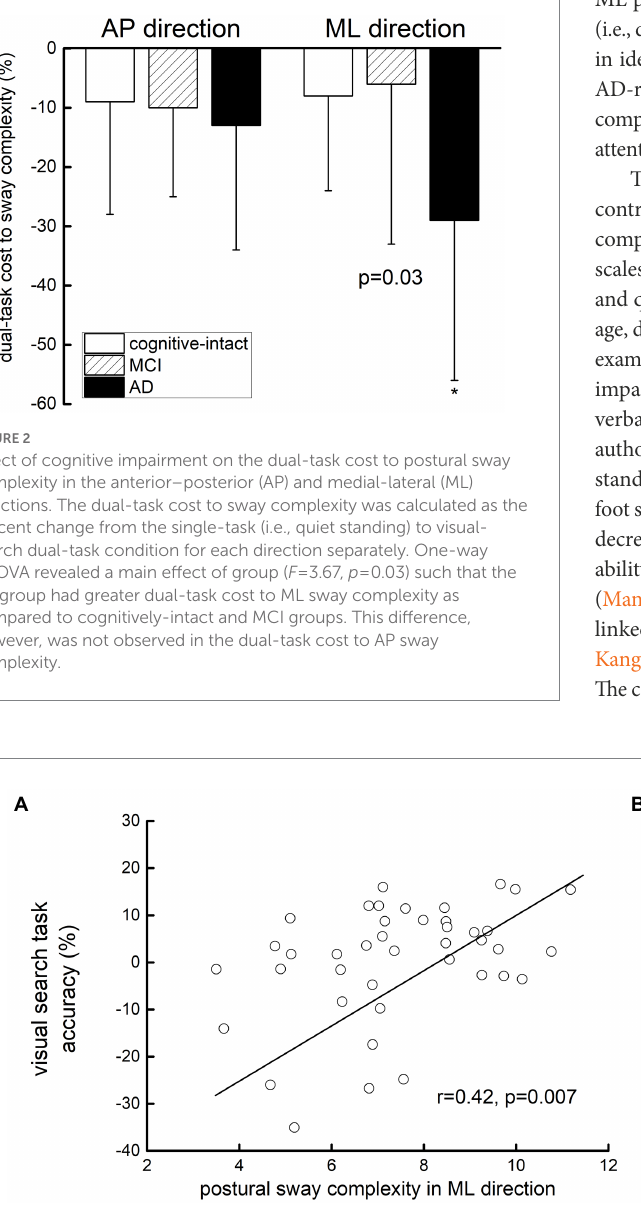
FIGURE 3 The association between visual-search performance and medial-lateral (ML) postural sway complexity (A) and the dual-task cost to this sway metric (B) . Visual-search task accuracy (%) was calculated as the number of target letters reported by the participant divided by the total number of target letters within the amount of letters scanned, multiplied by 100. Linear regression models showed that participants with lower ML sway complexity ( r = 0.42, p = 0.007) and/ or greater dual-task costs to ML sway complexity ( r = 0.39, p = 0.01) would have significantly lower accuracy of visual-search